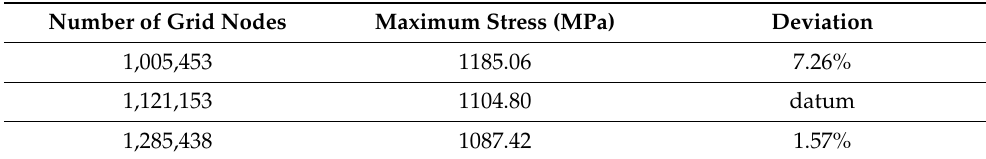
Table 3. Mesh convergence